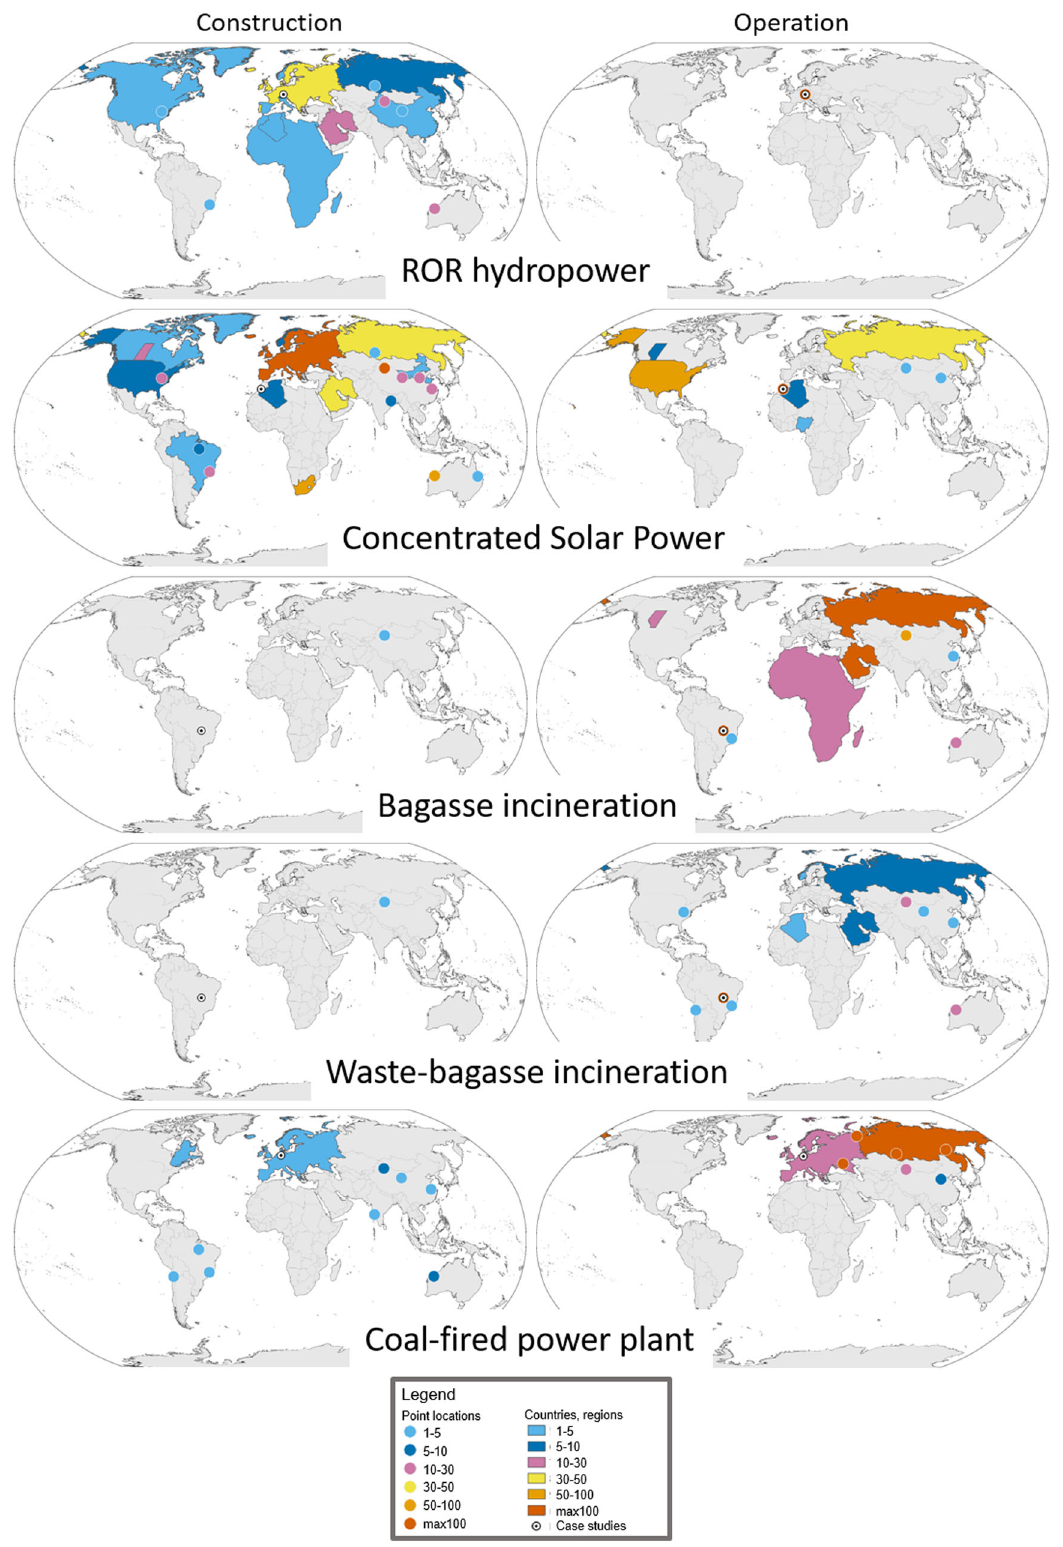
Fig. 5 Hotspots of environmental burdens of electricity generation systems in the construction and operation phase. Hotspots are marked in colour, they can be single points (represented by coloured circles), countries or regions (represented by coloured polygons). The colour indicates the ratio of a normalised hotspot results to the median of all case studies, whereas a value of 1 – 10 is regarded as a hotspot of low, 10 – 30 of medium, 30 – 50 of high and 50 – 100 as well as greater 100 of very high severity. High resolution maps of the single environmental pressures are available in Supplementary Figs. 1 – 7.